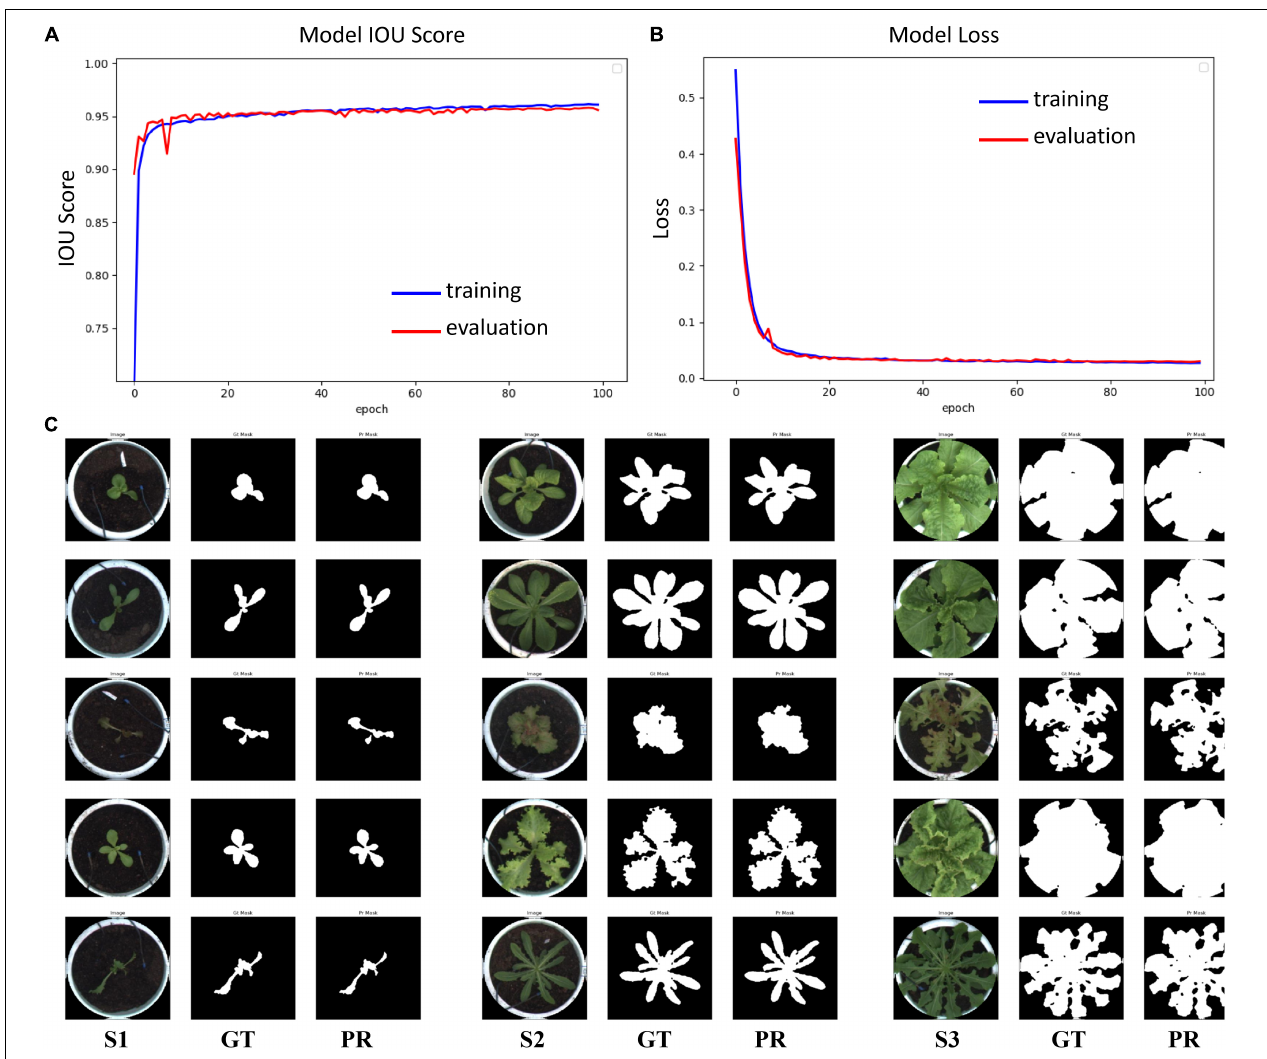
FIGURE 5 | Evaluation results of the semantic segmentation model. (A) IOU score, (B) Loss curve, (C) Segmentation results of lettuce plants in the test dataset at different growth points (S1, S2, and S3 respectively correspond to three growth points; GT refers to the manual annotation image in the test dataset; PR refers to prediction results of semantic